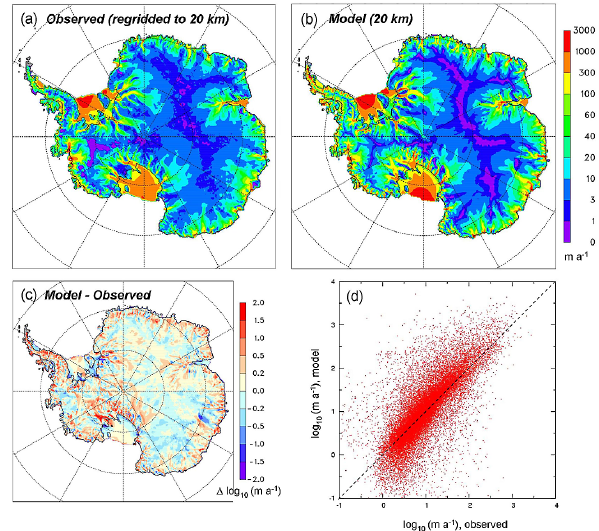
Fig. 5. (a) Observed surface ice velocities (Rignot et al., 2011), av- eraged here to 20-km model cells, ma − 1 . (b) Model surface ice velocities, ma − 1 , using inverse method with sub-grid topographic effect, 20-km resolution (as in Fig. C1d–f). (c) Model minus ob- served velocities, log 10 (ma − 1 ) , i.e., log 10 (v model /v observed ). Very slow velocities are ignored, i.e., if v model or v observed is less than 2ma − 1 , it is reset to 2ma − 1 for this plot. (d) Scatter plot of ob- served vs. model velocities, log 10 (ma − 1 ), for each 20-km grid cell with grounded ice. The same figure appears in